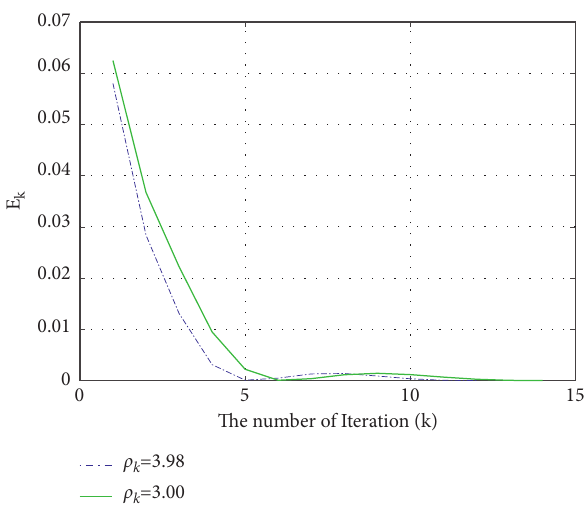
Figure 2: Error against iterations for Algorithm 1 with difference choices of ρ Table 2: Comparsion of Algorithm 1 and Scheme (97) for different choice initial point for ε � 10 − 4 Algorithm 1 with θ k � 0 . 8 Algorithm 1 with θ k � 0 . 0 Initiative point x 1